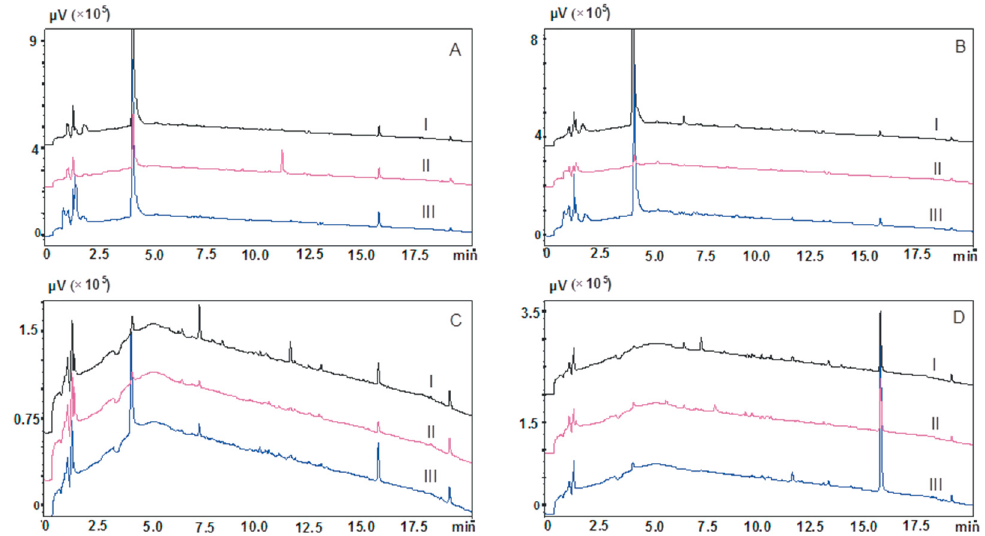
Figure 1. Chromatograms of blank saliva samples after elution of column with methanol. ( A )—procedure 1, ( B )—procedure 2, ( C )—procedure 3, ( D )—procedure 4; I—Strata X columns, II—Strata X-C columns, III—Strata X-CW columns.